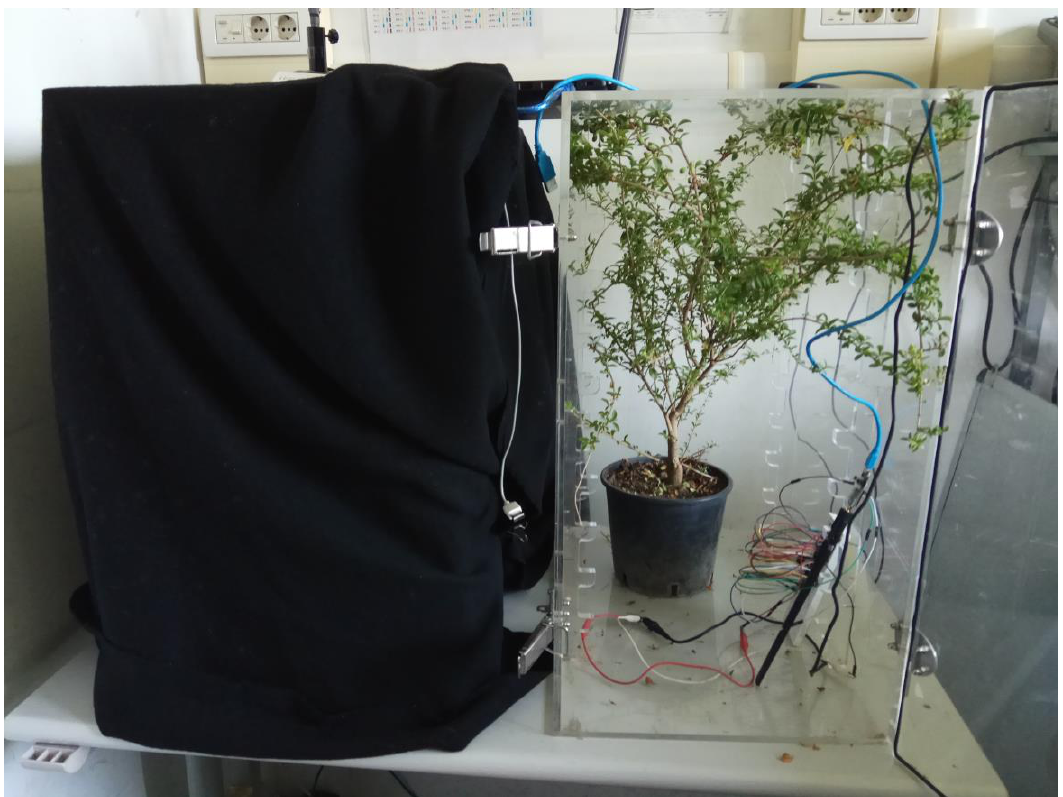
Figure 2. WSN test of plants enclosed in transparent boxes in order to simulate transport inside lorries. The transparent box shows an enclosed European privet. WSN and its antenna are also visible inside the box. The box is endowed with a series of holes for air